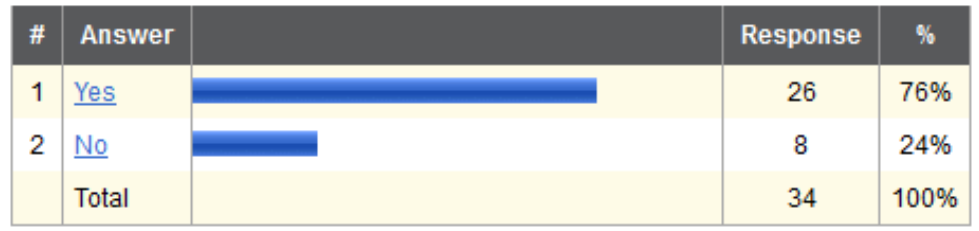
Figure 6. The response to Question 2b-1: Does closeness change your stand about the project?